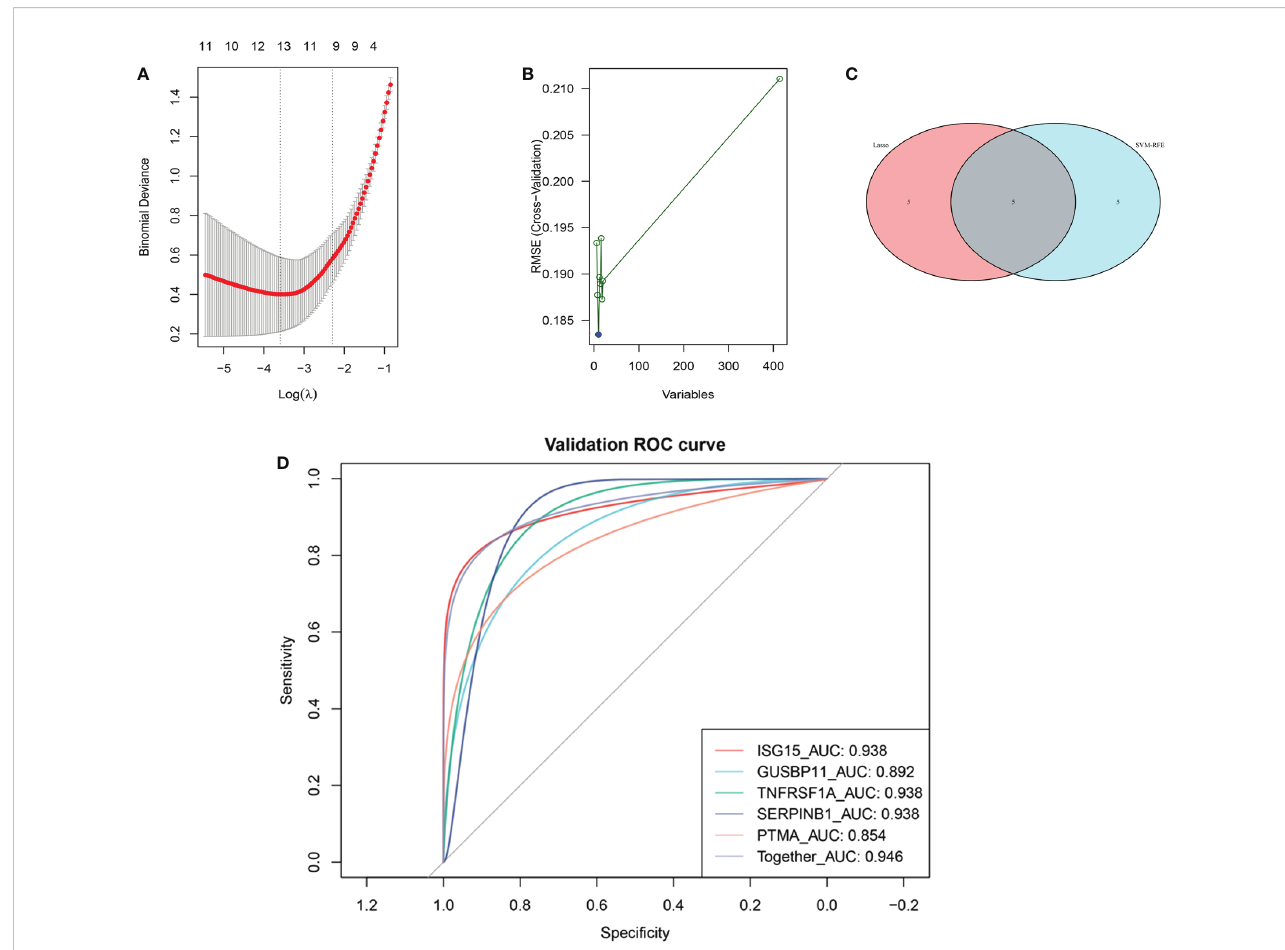
FIGURE 4 Machine learning-based screening biomarkers and veri fi cation with ROC curves. (A) Ten genes screened by LASSO logistic regression algorithm. (B) Ten genes screened by SVM-RFE algorithm. (C) The fi ve overlapping genes obtained by both the LASSO and SVM-RFE algorithms. (D) ROC curves for the diagnostic biomarkers in the validation dataset